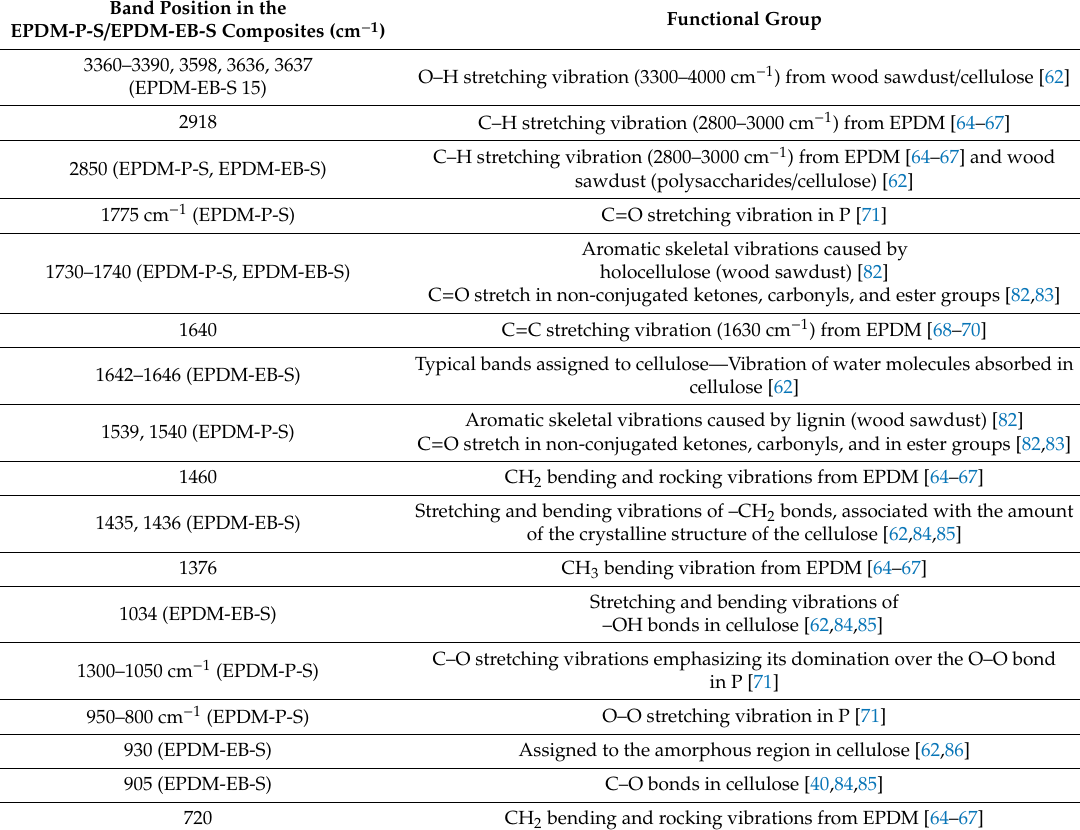
Table 1. Band assignments in EPDM-P-S and EPDM-EB-S